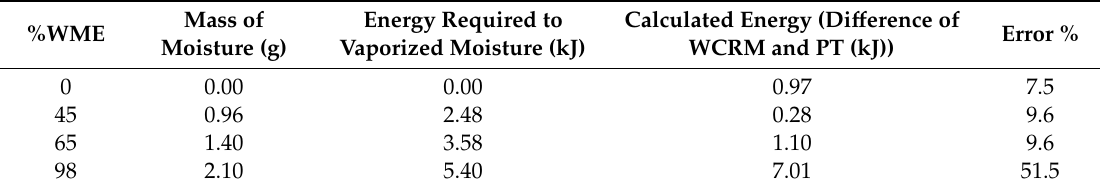
Table 2. Details of moisture content and vaporization heat (0%, 45%, 65%, and